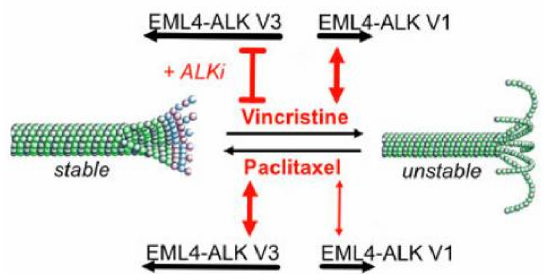
Figure 5. Combination of microtubule poisons and ALK inhibitors in EML4-ALK-driven NSCLC. Microtubules are dynamic structures and the balance between their polymerization and depolymer- ization determines microtubule stability. The microtubule poisons, vincristine and paclitaxel, promote the depolymerization and polymerization of microtubules, respectively. EML4-ALK V3 strongly stabilizes microtubules, whereas EML4-ALK V1 has a weak destabilizing effect. In combination with ALK TKIs, microtubule poisons that act in the same direction of microtubule stability could lead to enhanced loss of cell viability in EML4-ALK V1 and V3 patient